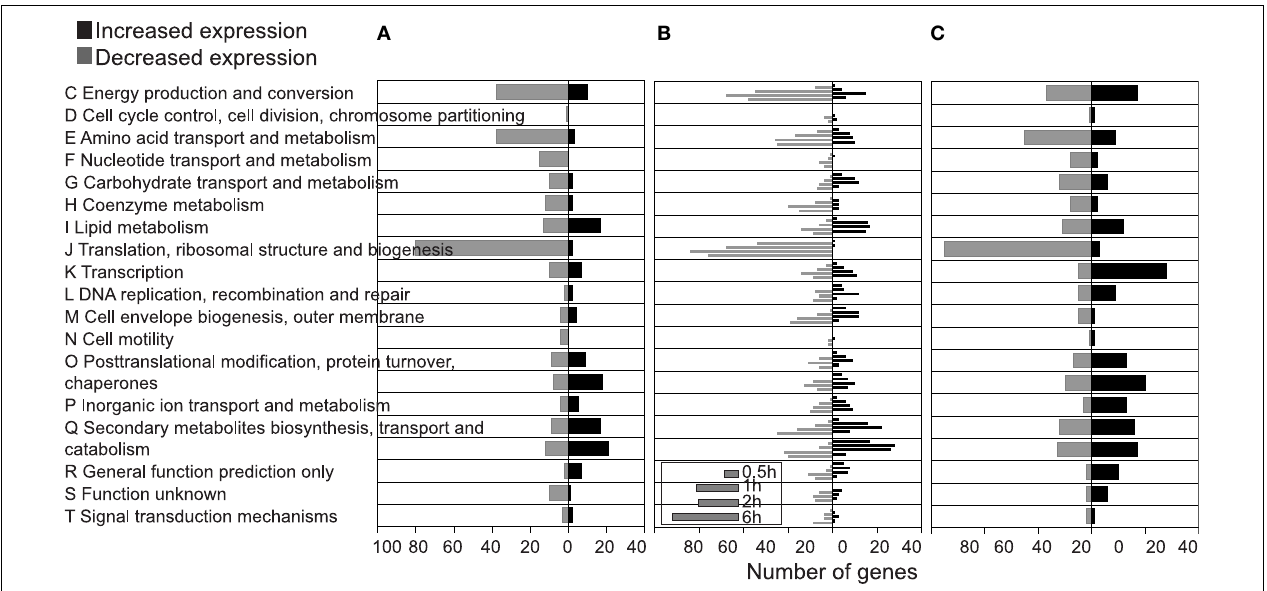
to DBF in chemostats, and (C) growth on DBF in batch culture. Note that (B) shows data sets from the four time points after addition of DBF to the chemostat (see inset).